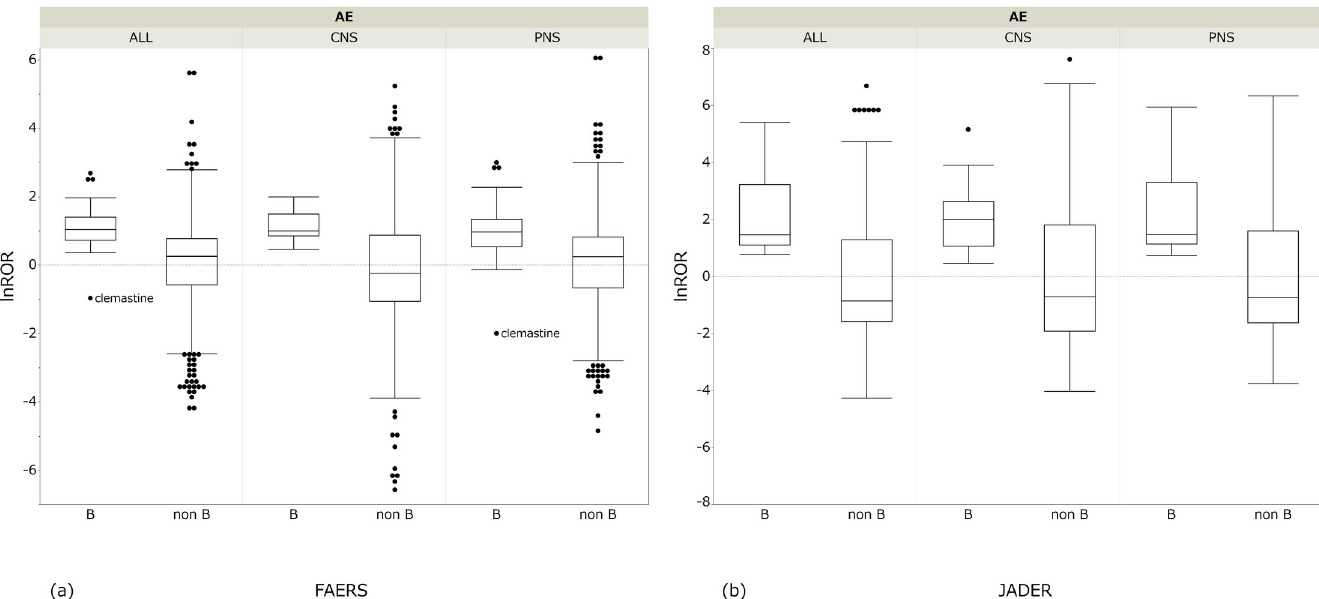
Fig 6. Comparison of Beers Criteria 1 anticholinergic drugs and other drugs. These box plots show the distribution of the lnROR by the anticholinergic drugs and the other drugs. (a) FAERS and (b) JADER.